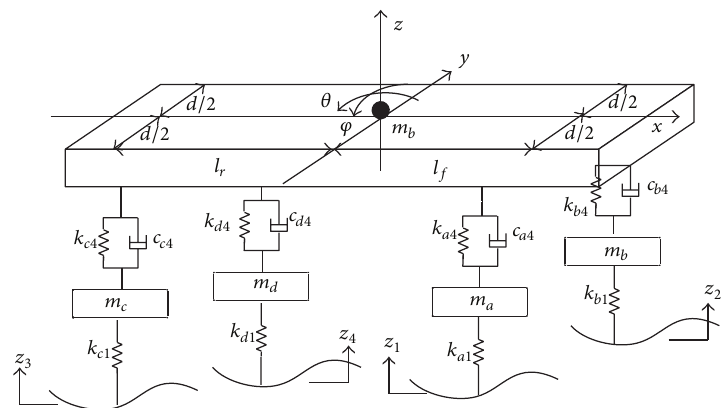
Figure 7: The simplified physical model.